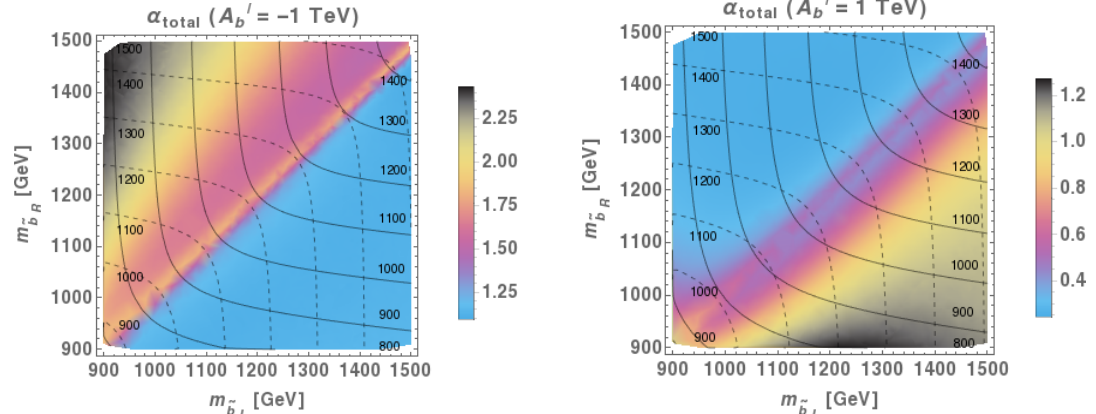
Figure 16 . Variations of (cid:11) total in the NHSSM and in the MSSM in the m ~ A 0 = 1 TeV (left) and A 0 = 1 TeV (right) and for (cid:12)xed values of tan (cid:12) (=40) and (cid:22) (=200 GeV). b b (cid:0) Other (cid:12)xed parameters are as in (cid:12)gure 15. Contours of constant m ~ (dashed) lines along the right (left) edges of the plots.